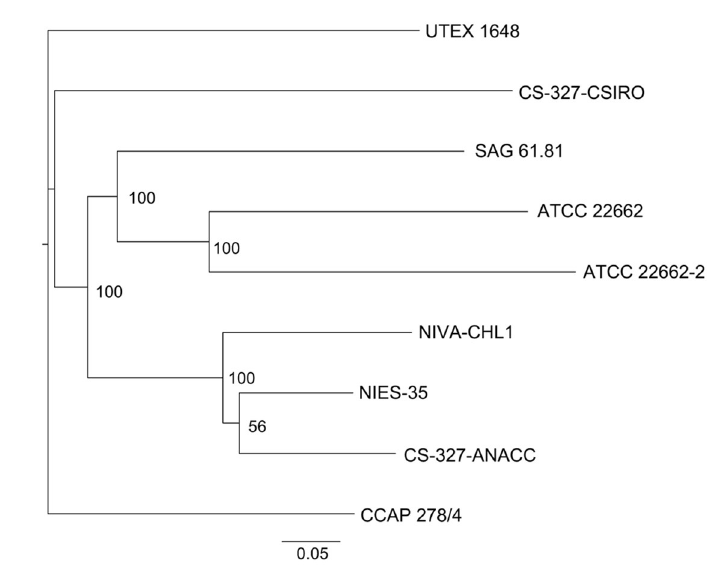
Fig 3. Unrooted molecular phylogenetic tree based on single-nucleotide polymorphisms. The tree was constructed using the maximum likelihood method with RAxML (GTR+ Γ ). Bootstrap values (if higher than 50%) are given along the branches. Scale bar shows the number of substitutions per